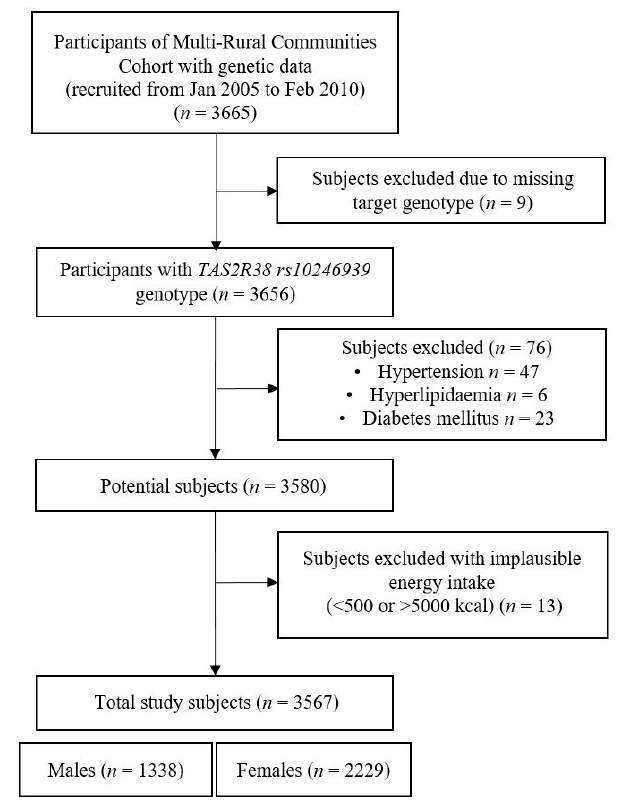
Figure 1. Simplified process of subject selection in the present study.